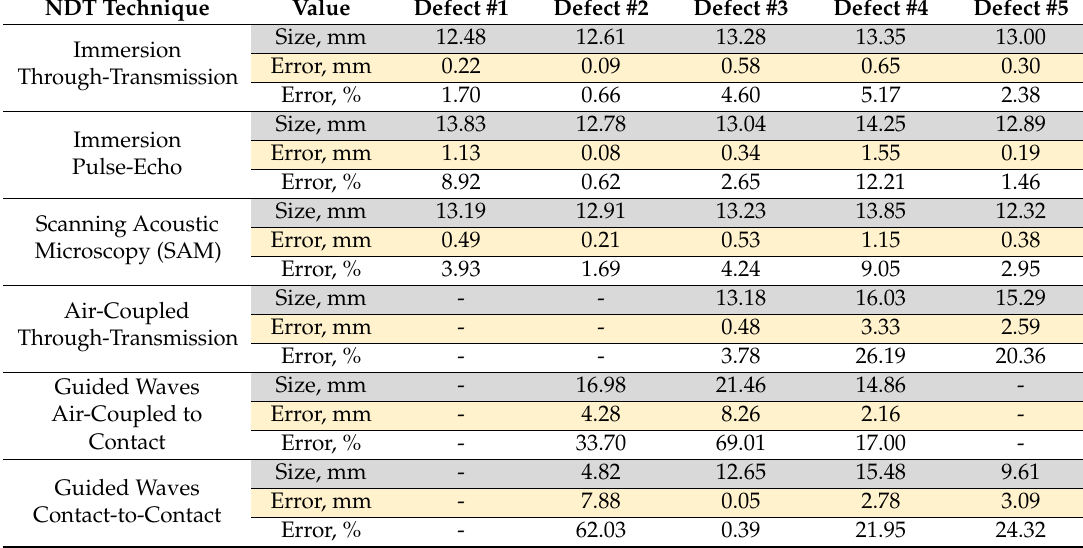
Table 3. The measured defect dimensions and relative errors for di ff erent ultrasonic NDT techniques over five debonding